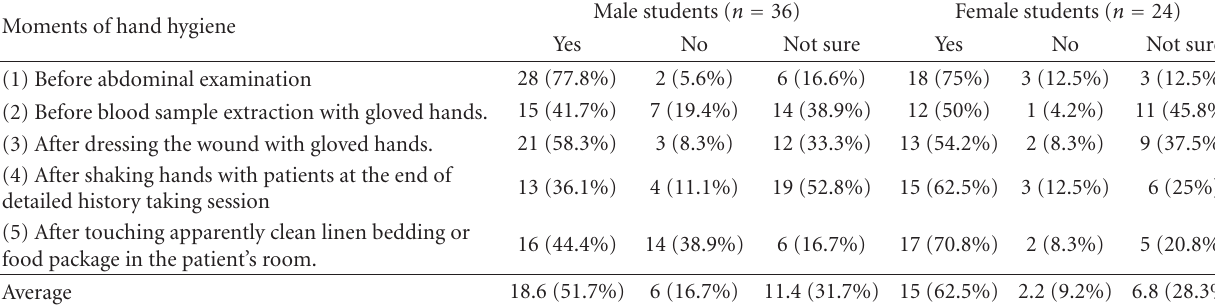
Table 3: Hand hygiene awareness among medical